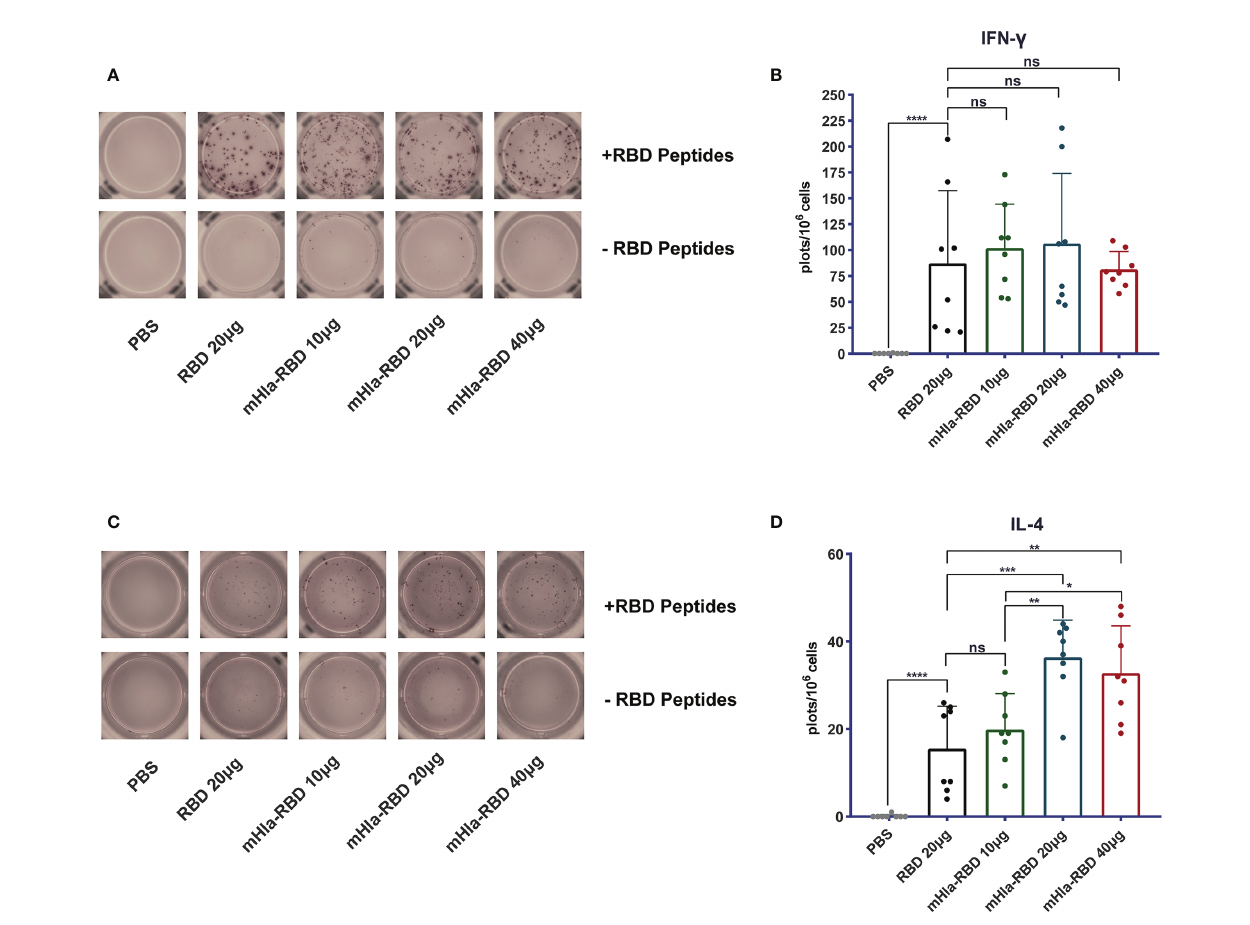
FIGURE 3 | Detect of cellular response induced by RBD and mHla-RBD immunization. ELISpot analysis of IFN- g (A) and IL-4 (C) secretion by splenocytes from immunized BALB/c mice. One-way ANOVA with Tukey ’ s multiple comparisons, *p <0.05, **p <0.01, ***p <0.001, ****p <0.0001; ns, not signi fi cant. Representative images of IFN- g (B) and IL-4 (D) ELISpot